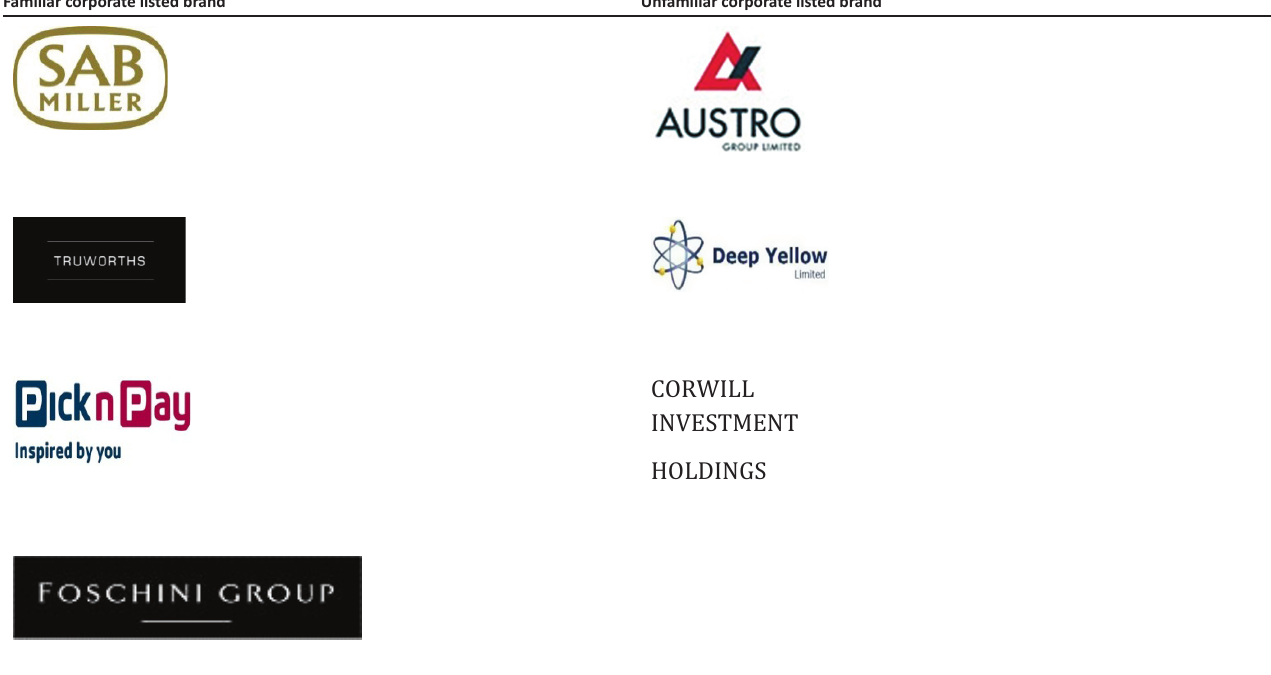
TABLE 1: Familiar and unfamiliar corporate listed brands. Familiar corporate listed brand